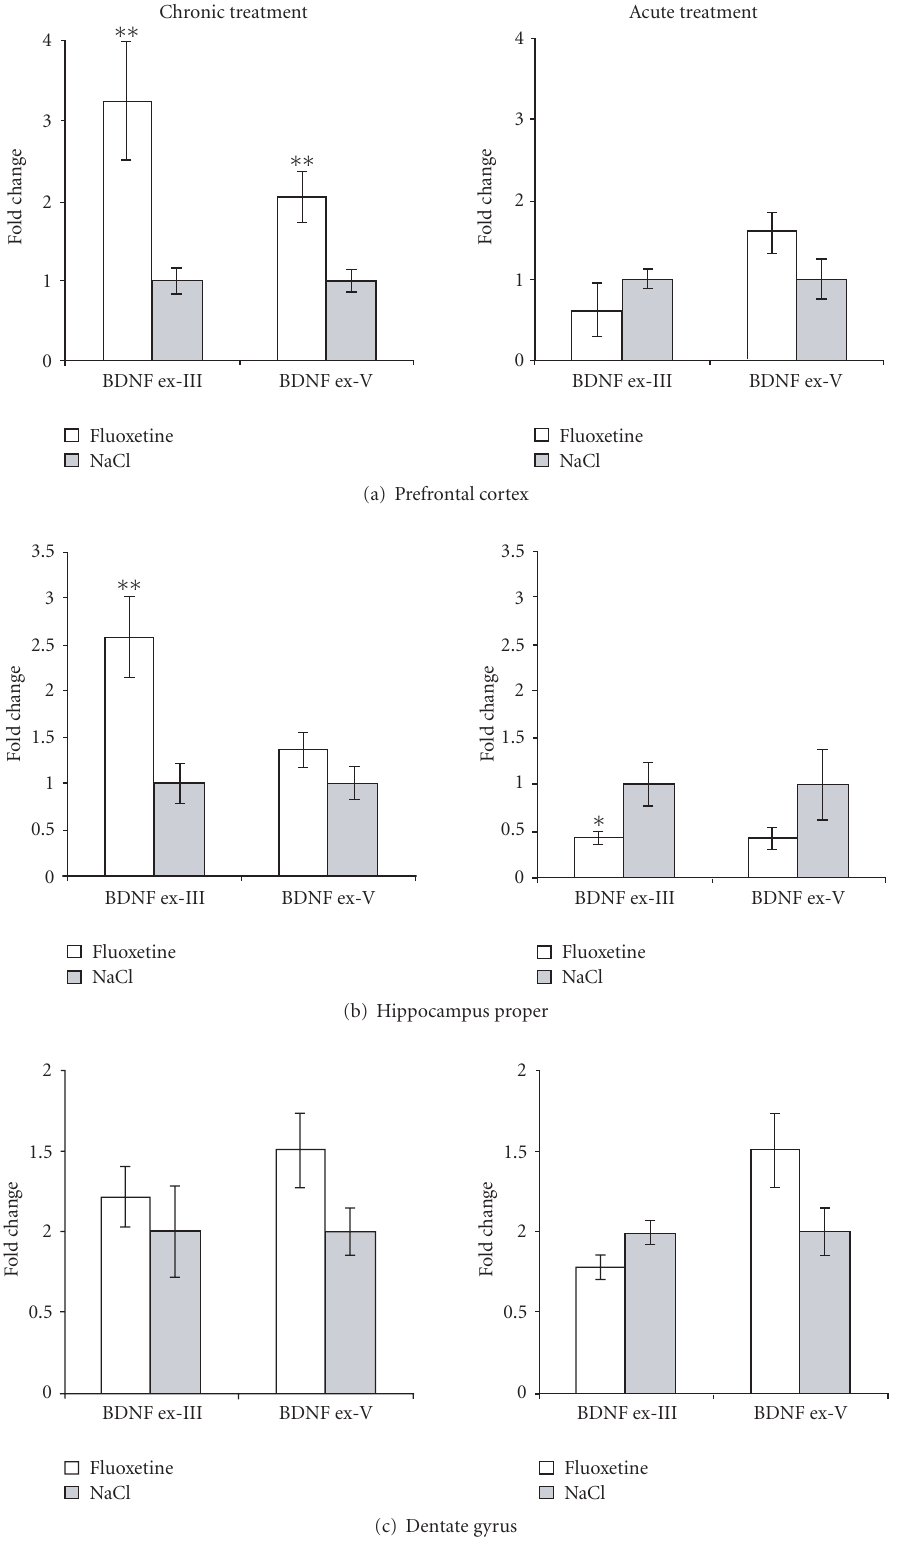
Figure 2: Brain region-specific upregulation of BDNF exon-III specific mRNA in chronic fluoxetine-treated rats. (a) Prefrontal cortex, (b) hippocampus proper, (c) dentate gyrus. N = 7 fluoxetine chronic, n = 8 NaCl chronic, n = 5 fluoxetine acute, n = 4 NaCl acute. ∗ P < . 05, ∗∗ P < . 01 Student’s t